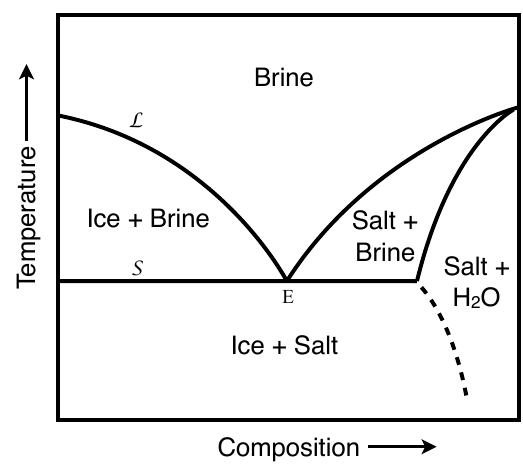
Fig. 4. An example of an equilibrium phase diagram for a binary solution comprised of two components, water and a typical soluble mineral salt. The lines separate regions of different phases. The liq- uidus ( L ) separates the region in which the system is completely liquid, with salt completely dissolved in liquid water forming a brine, from a region in which solid and liquid coexist. Likewise, the solidus ( S ) separates the latter region from the region where all of the material is solid. These two lines intersect at the eutectic point E. At salt concentrations above the eutectic water may be found in liquid brine, ice, or molecularly incorporated into salt crystals (salt+H 2 O).